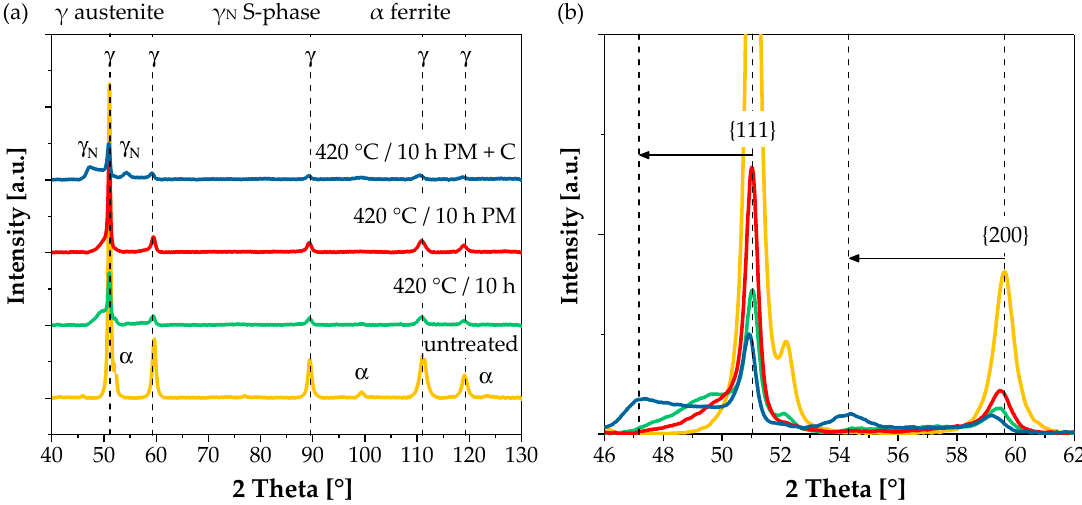
Figure 3. XRD diagrams of AISI 316L HVOF coatings before and after gas nitriding: ( a ) overview; ( b ) detailed view of the peak shift of {111} and {200} lattice planes.